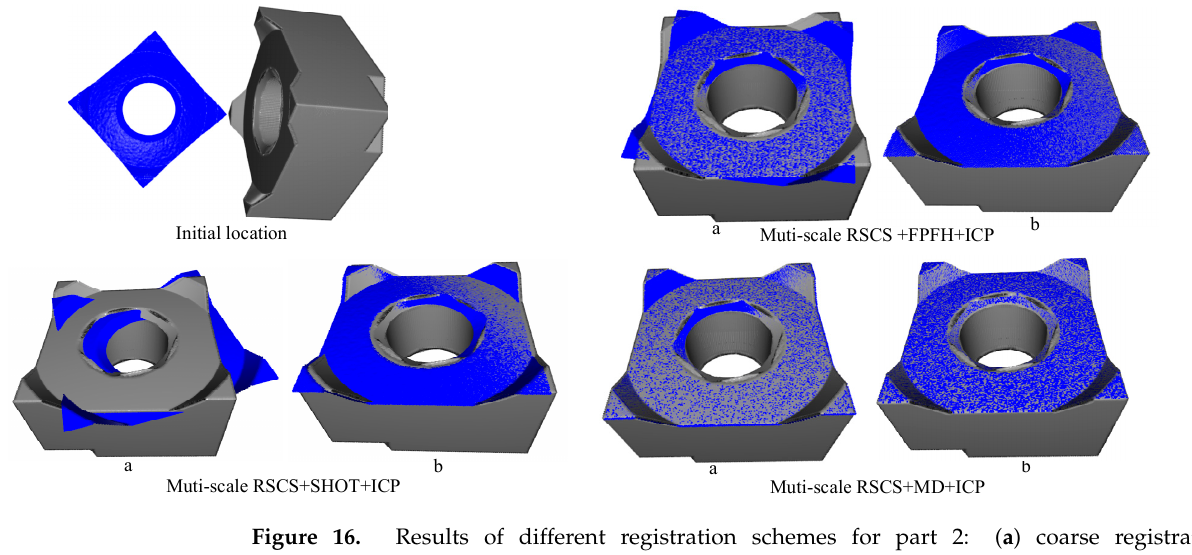
Figure 15. Results of different registration schemes for part 1: ( a ) coarse registration; ( b ) fine regis- tration.